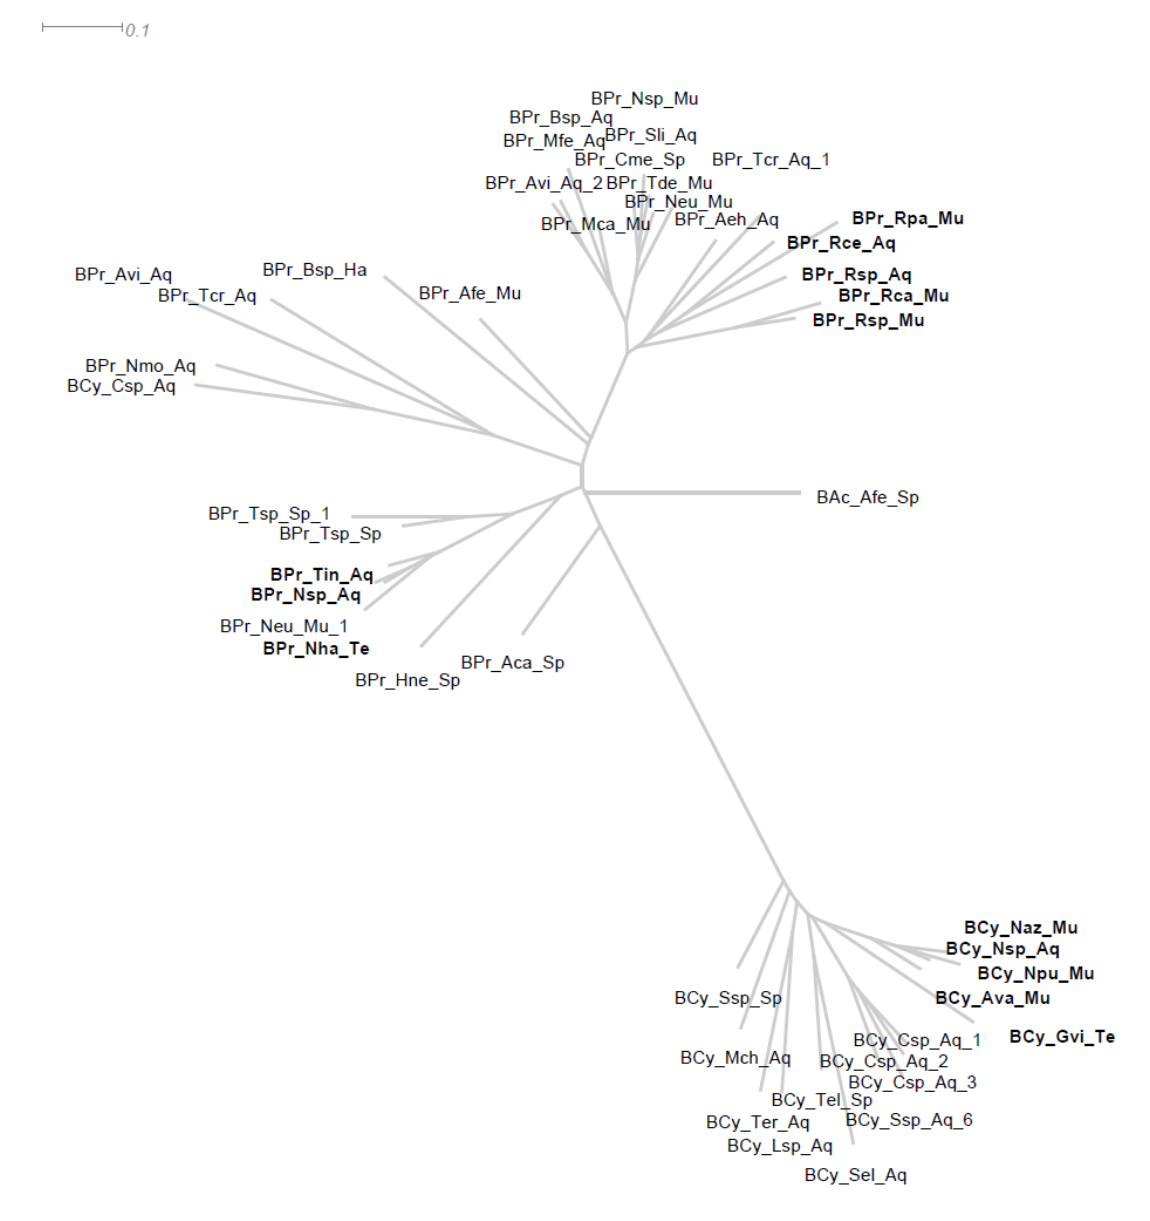
Fig. 3: A phylogeny for the small subunit of bacterial RubisCO. The sequences were collected by using BLAST and stored in a multiple fasta file. Labels created by utilizing Key2Ann and the options superkingdom phylum habitat replaced the NCBI-labels. The resulting file was processed by means of Jalview [15] and SplitsTree4 [17]. In the Key2Ann labels the first three characters indicate the phylogenetic lineage, i. e. “B” Bacteria, “Pr” proteobacteria; the following infix gives the name of the species. The infixes “Aq”, “Te“, “Mu”, “Sp”, “Ha“ specify the habitat as aquatic, terrestrial, multiple, specialized, and host-associated. The tree shows that phylogenetic relationship and not the habitat determines the composition of the proteins. The entries printed in bold indicate that in three bacterial phyla the proteins from aquatic and terrestrial species (infixes “Aq”, “Te” and “Mu”) are grouped according to their phylogenetic lineage and not related to the habitat. A number is added if the same label was generated for two sequences (e. g. for paralogous